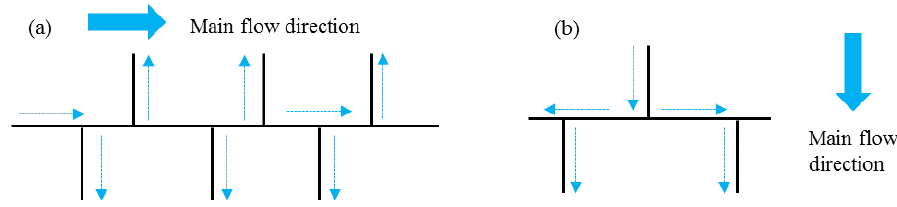
Figure 17. Effect of the correlation between the topological structure of the fracture network and main direction of fluid flow. ( a ) Fluids flow along the long straight fracture, ( b ) seepage through multiple intersecting short fractures.